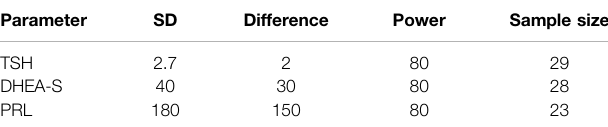
TABLE 1 | Calculationofthesamplesizebasedonthedifferenceinchange(pre-post) ofthelevelsofthyroid-stimulatinghormone(TSH),dehydroepiandrosterone-sulfate (DHEA-S), prolactin (PRL).